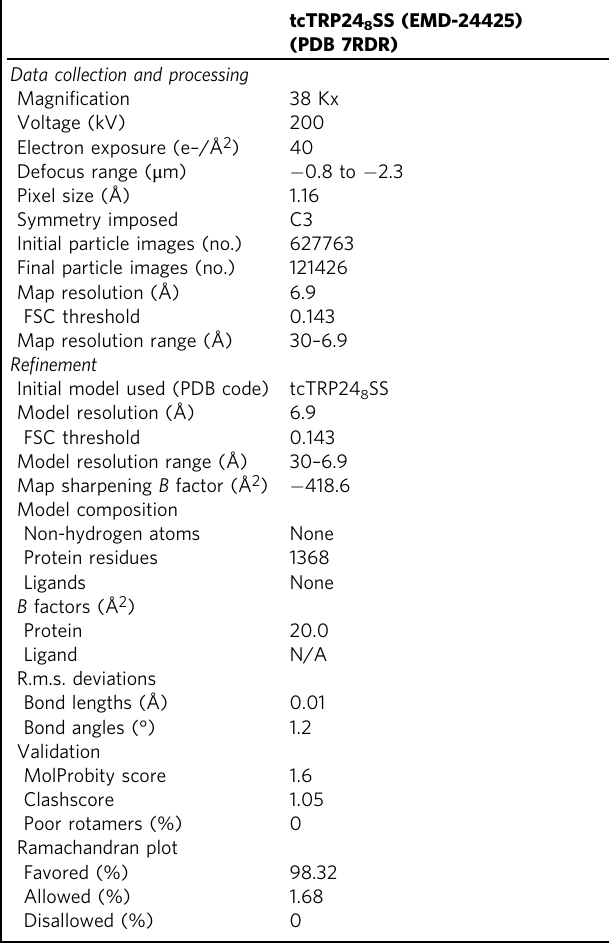
Fig. 5 Assembly behavior of tcTRP24 8 and tcTRP24 8 SS. a Size-exclusion chromatographic (SEC) elution pro fi les of the original ‘ tcTRP24 8 ’ homotrimeric